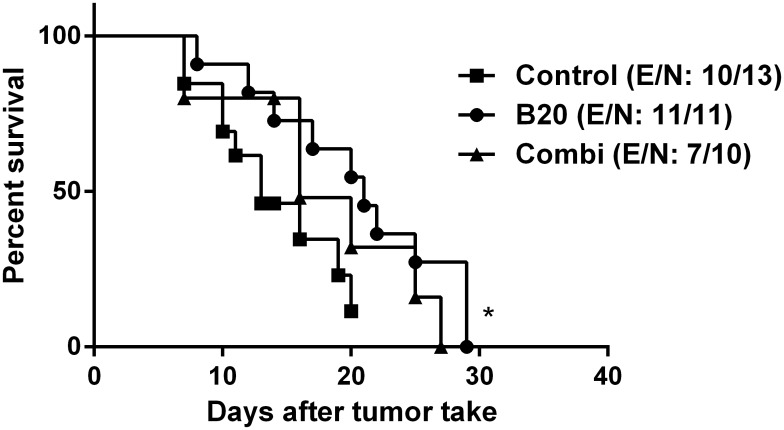
Survival analysis.Kaplan Meier survival curves from tumour take. Control group vs. B20 group, 13 vs. 21 days; p = 0.04; HR = 0.5; 95% CI: 0.13–0.82 (determined by log-rank test). E: events, N: number of animals